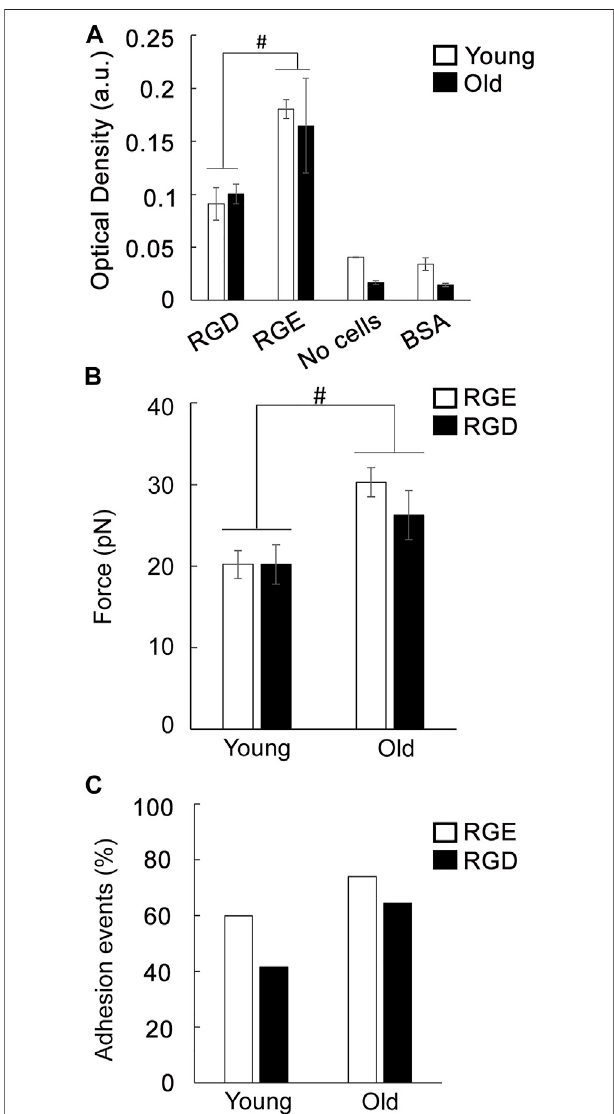
FIGURE 5 | (A) Adhesion assay of VSM cells to fi bronectin was performedinthepresence ofafunctionalintegrinblocking RGDpeptide anda non-blocking RGE peptide. Negative control experiments were performed using untreated cells plated on substrates blocked with BSA, and speci fi c matrix without cells. Data are presented as mean ± SEM. (B) FunctionalAFMmeasurementsofintegrin α 5 β 1bindingforceto fi bronectin for young and old VSM cells treated with a functional integrin blocking RGD peptide and a non-blocking RGE peptide are shown. For comparisons, force peak values whose con fi dence intervals did not overlap were considered signi fi cantly different ( p < 0.05). (C) Percent of adhesion events for each treatment is